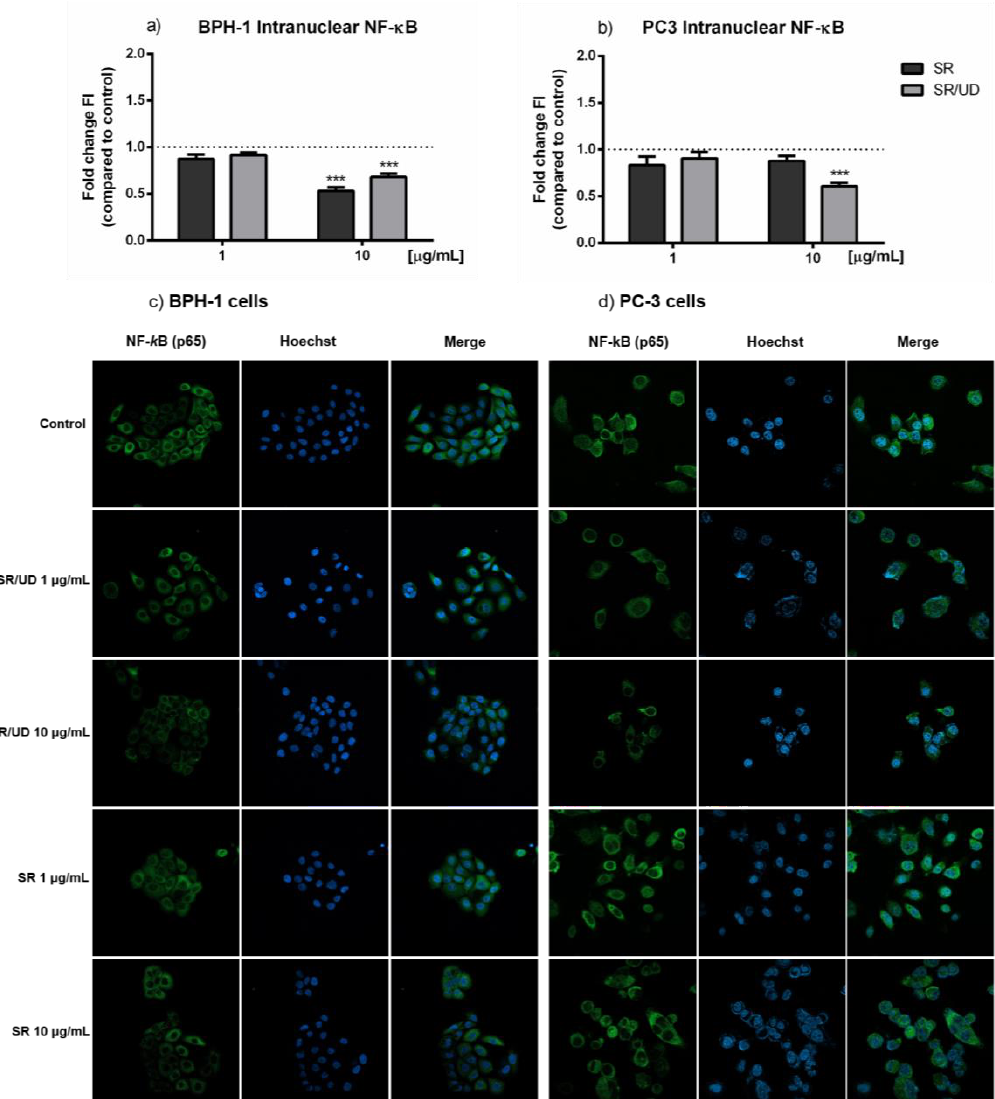
Figure 3. Effect of 24 h treatments with SR and SR/UD (1, 10 µg/mL) on nuclear translocation of NF-κB in BPH-1 and PC3 cells. ( a , b ) Quantification of intranuclear NF-KB in BPH-1 cells ( a ) and PC3 cells ( b ). Values are expressed as the ratio between treatments and control. Data represent the mean ± SEM ( n = 3). *** p < 0.001, treatment compared to the control (indicated as the dashed line). ( c , d ) Representative images of NF-κB immunofluorescence staining in BPH-1 cells ( c ) and PC3 cells ( d ) treated with SR and SR/UD. Images were captured at 60X magnification.